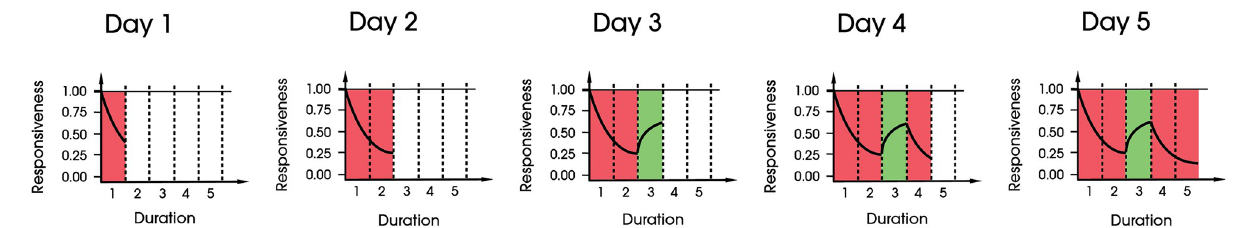
Fig 1. Example illustrating the impact of repeated ineffective/unwanted contacts on node